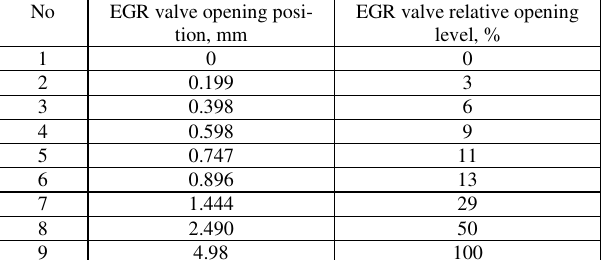
Table 2. Operating points of EGR valve No